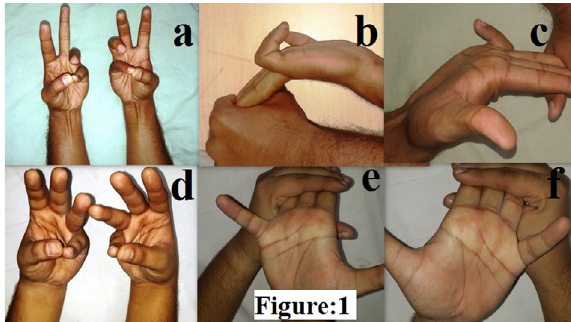
Figure 1. (a) Schaeffer’s test demonstrating the presence of palmaris longus bilaterally, (b) and (c) standard test demonstrating the functional presence of flexor digitorum superficialis of the little finger bilaterally, (d) Schaeffer’s test demonstrating the absence of palmaris longus bilaterally, (e) and (f) standard test demonstrating the functional absence of flexor digitorum superficialis of the little finger